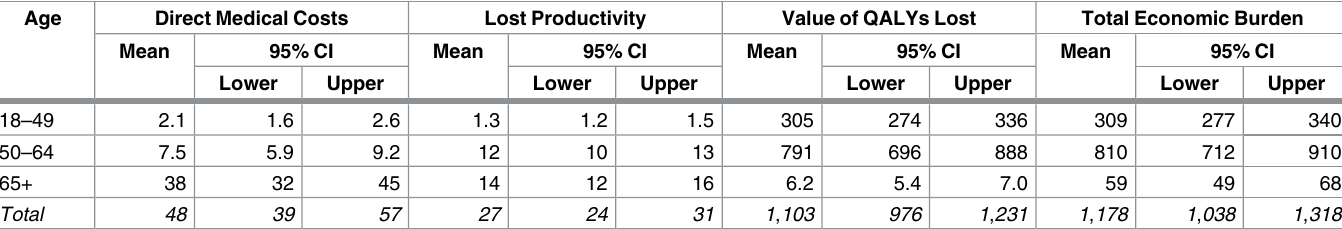
Table 11. Annual estimates of economic burden using direct medical costs, lost productivity and monetary value of quality adjusted life years (QALYs) lost based on all-cause influenza-attributed mortality by age group in millions of US Dollars averagedover five respiratoryseasons. Age